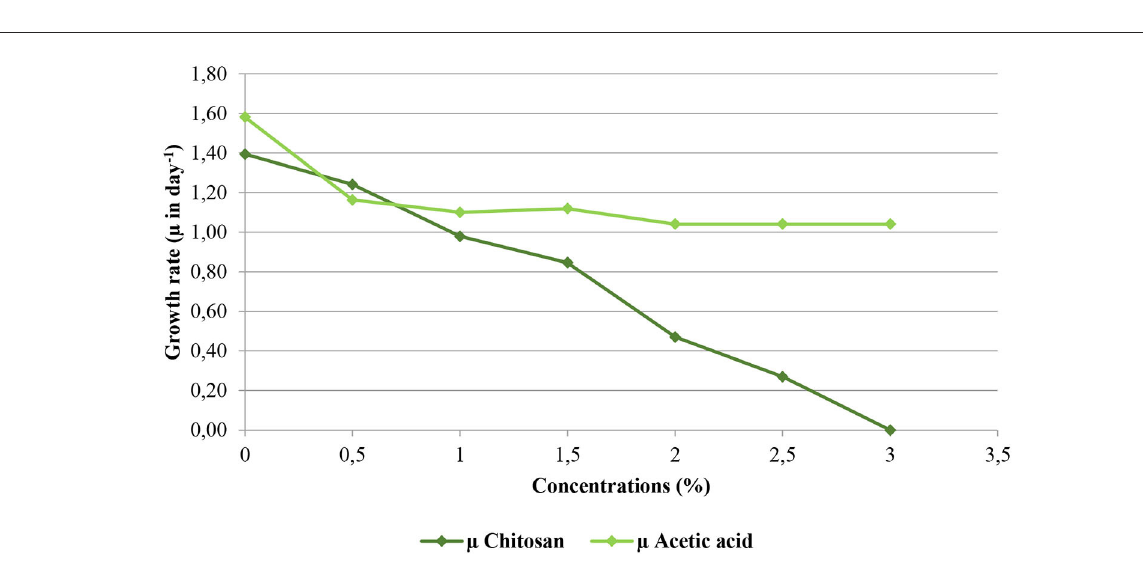
shows the growth rates ( µ in day − 1 ) of Aspergillus niger according to the concentrations of chitosan and acetic